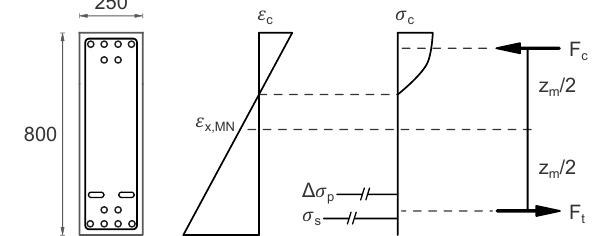
Figure 2. Investigated cross section [mm], strain, stress, inner forces and decisive strain ε x , MN due to bending and axial forces